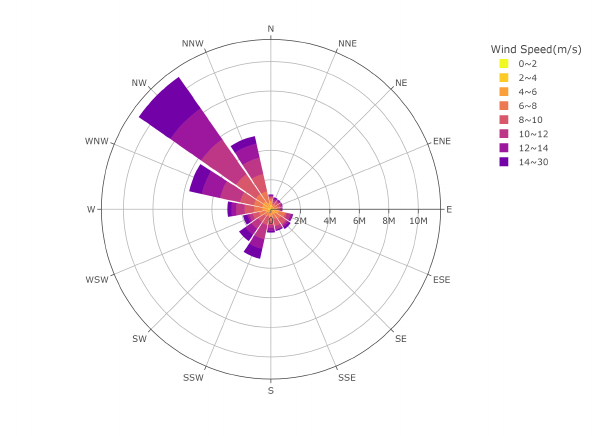
Figure 5. Relation with wind direction and wind power